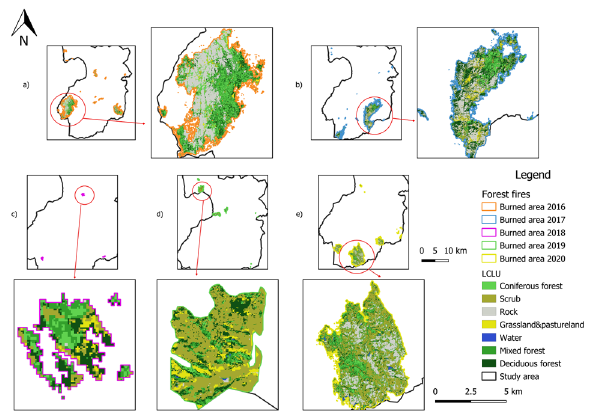
Figure 6. LCLU classes located in the burned areas (a) 2016-